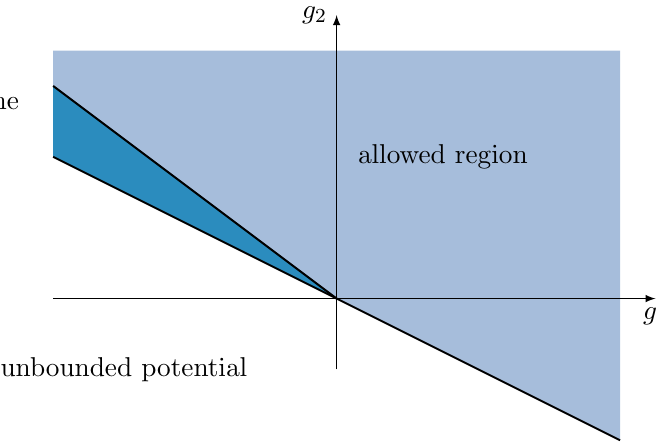
Figure 1 . The validity regions in the ( g 1 ; g 2 ) plane. In the upper region ( (cid:14) > 6) the large charge expansion is valid for any (cid:12)xed choice of J ( (cid:26); (cid:18) ). In the leftmost wedge (0 < (cid:14) < 6) there is a perturbative meaningful expansion only for certain values of (cid:18) . The bottom region ( g 0 < 0) is not allowed because the scalar potential is not